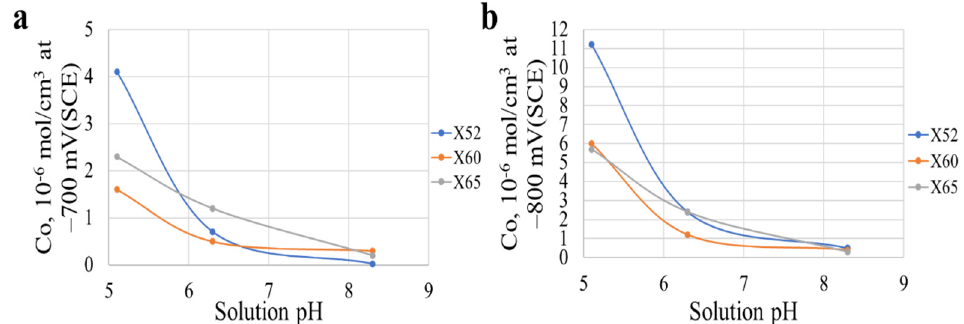
Figure 15. Variations in hydrogen concentration values on the exposed carbon steels at varying pH of the NS4 solution: ( a ) at applied potential of − 700 mV (SCE); ( b ) at applied potential of − 800 mV (SCE). Data from [73].